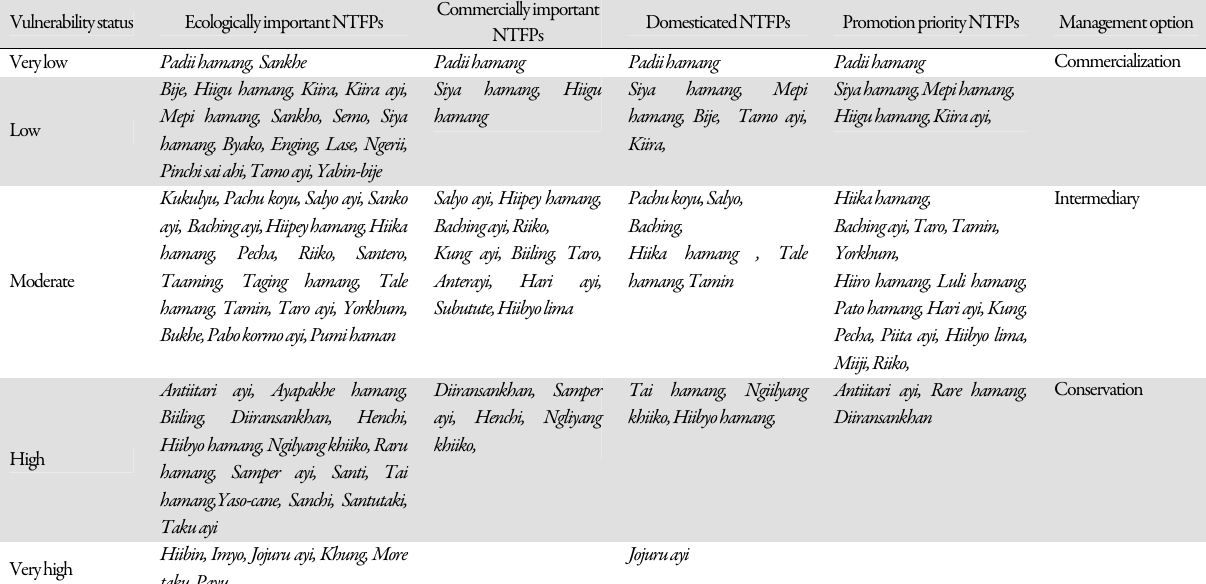
Table 4. NTFP matrix indicating management options for different NTFPs based on qualitative evaluation by the Ziro Valley